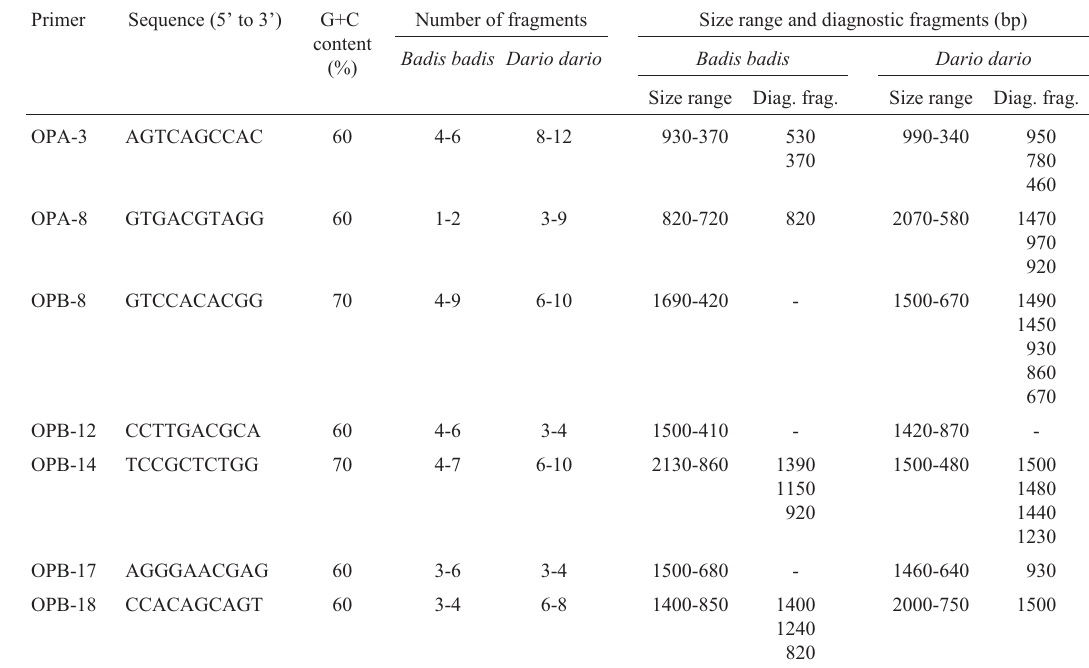
Table 1 - Number and size of fragments amplified by different RAPD primers used and molecular weight of diagnostic markers for Badis badis and Dario dario